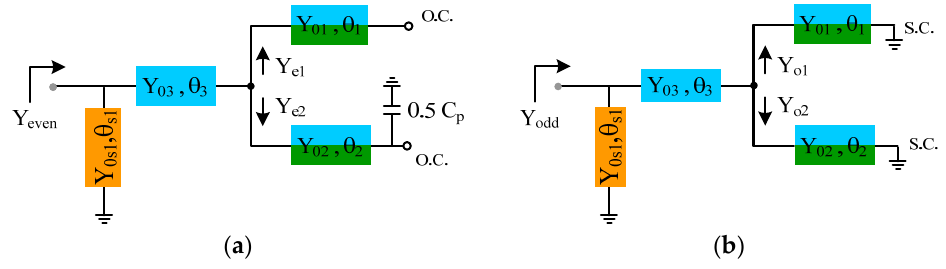
Figure 6. ( a ) A bandpass filter circuit by using a square loop resonator with perturbation element and short-circuited stubs ( b ) TL model ( c ) LE model ( d ) frequency response.